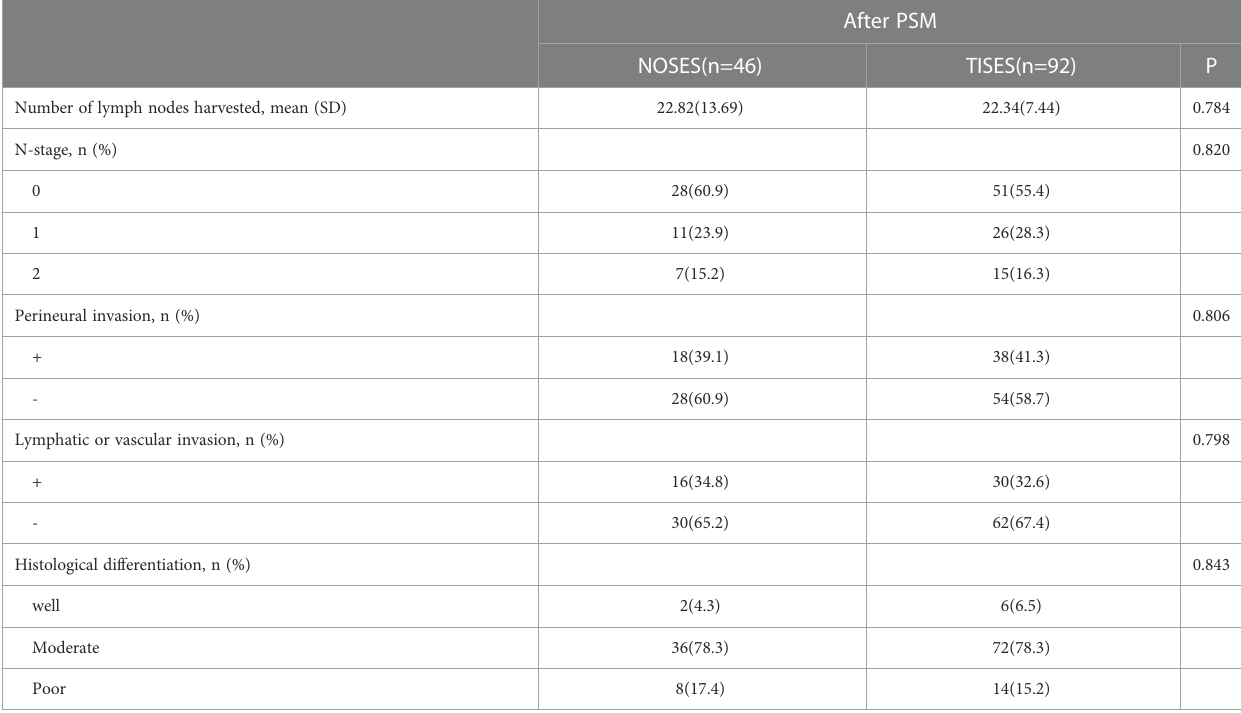
TABLE 4 Comparison of the postoperative pathological fi ndings between the NOSES group and the TISES group.